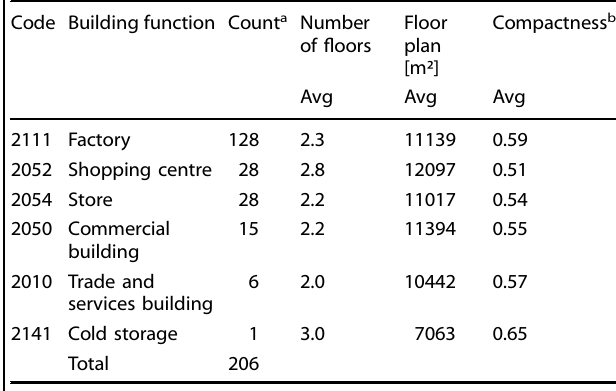
Table 2. Buildings with promising functions to integrate aquaponics or